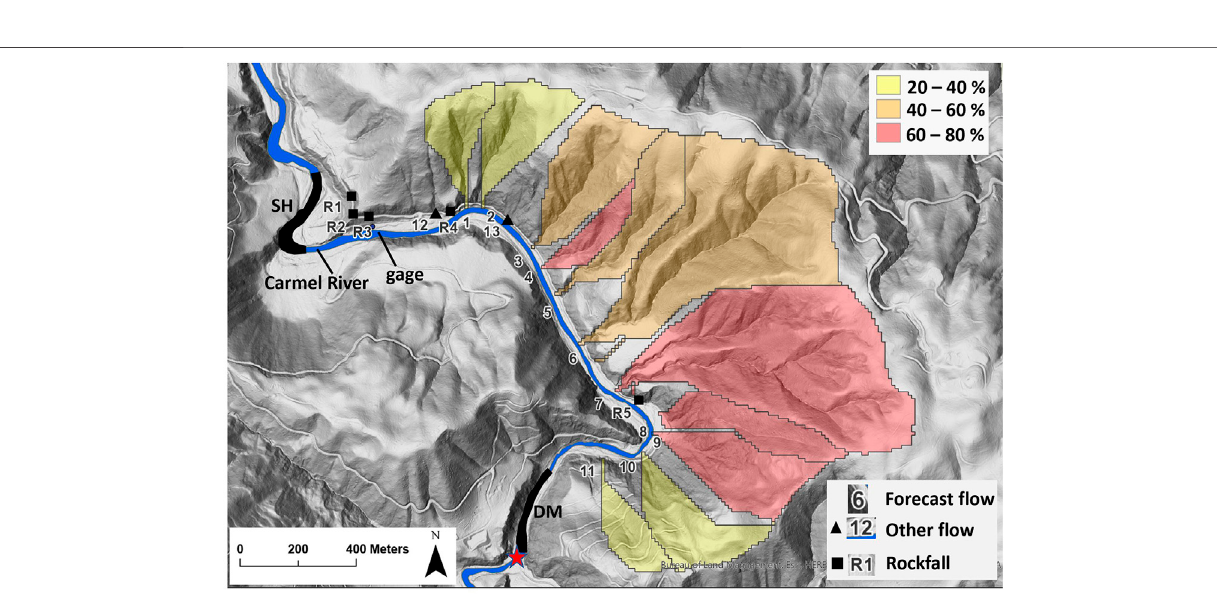
Frontiers in Earth Science |